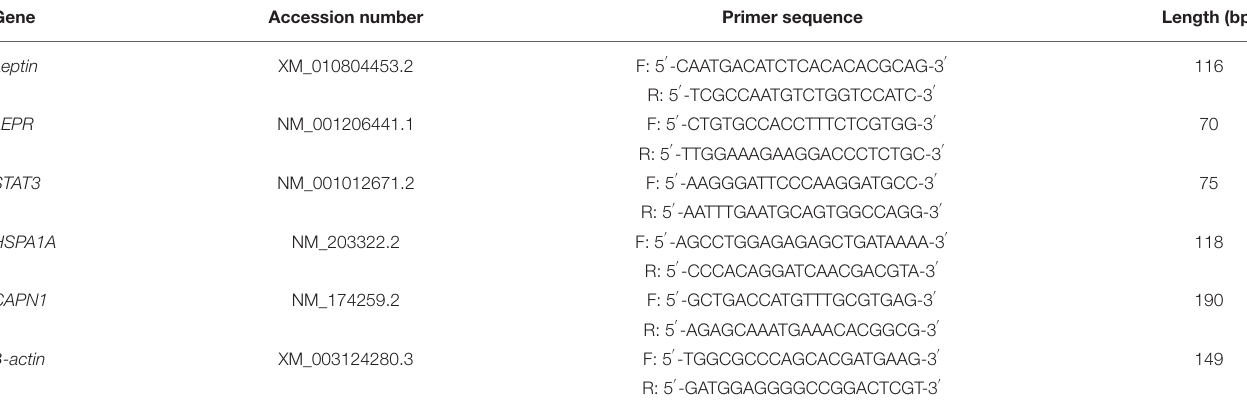
TABLE 1 | Information of primer sequences.